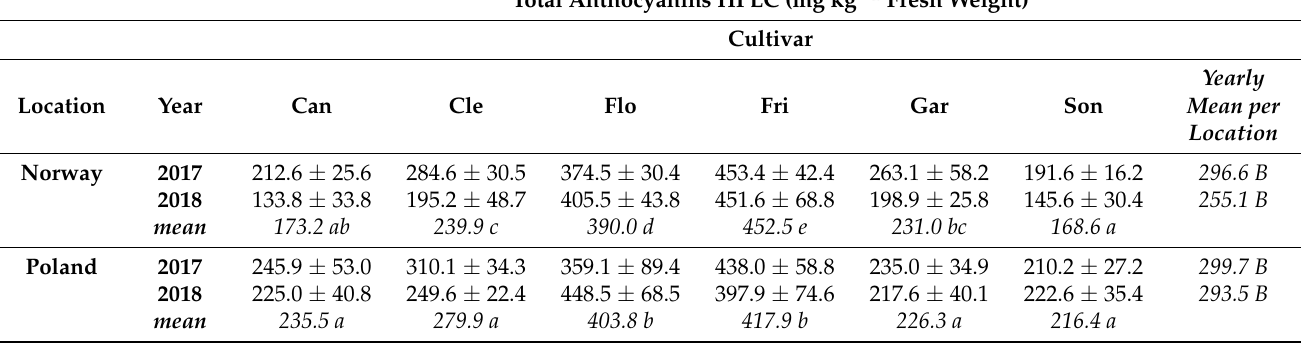
Table 2. Effect of growing location and year on total anthocyanin content as the mean of two picking dates in fruits of six strawberry